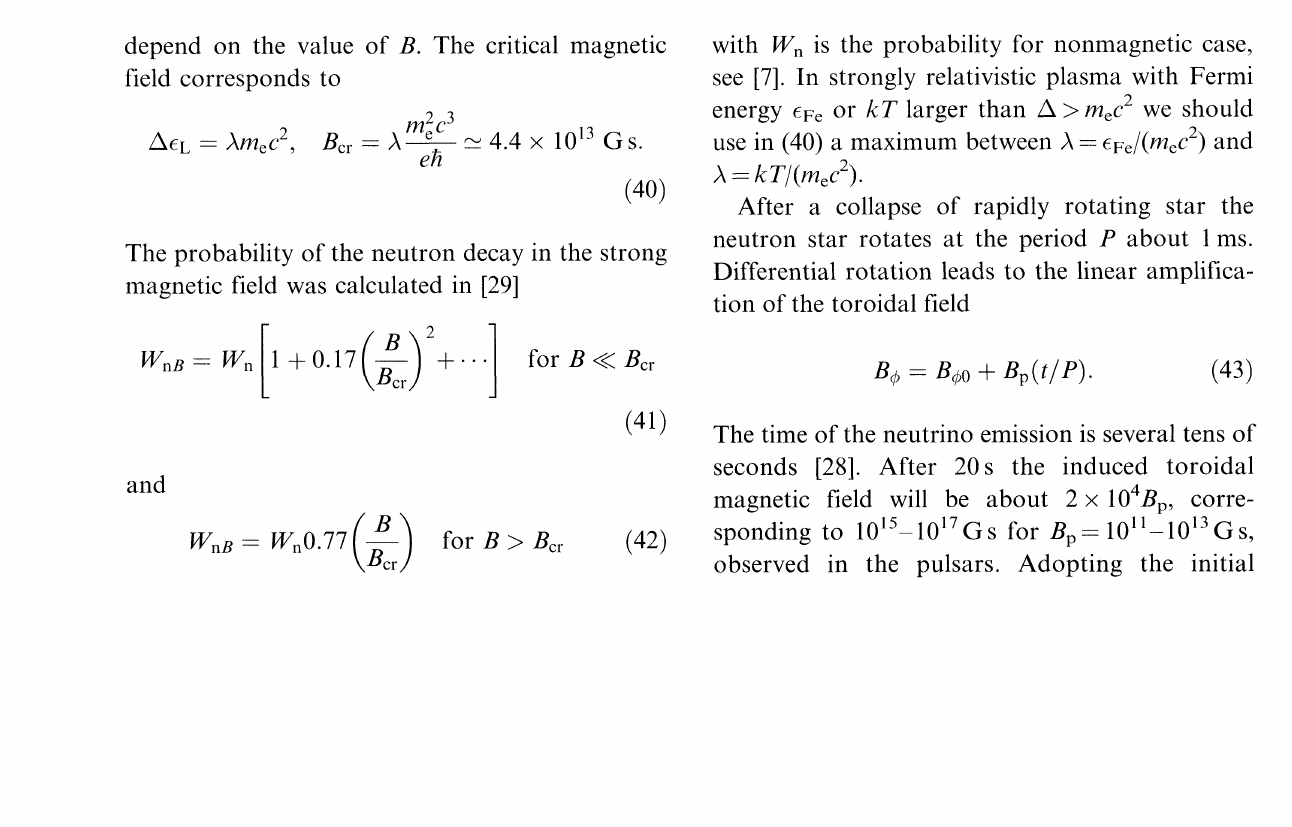
FIGURE 8 Density contours and velocity field at t-46.11, from